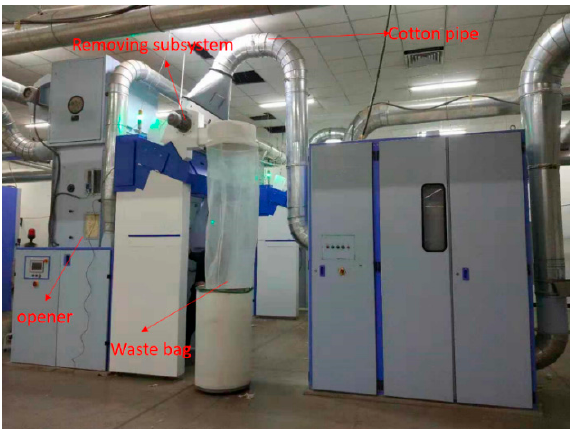
Figure 14. The deployed fiber cleaning machine on the production line.